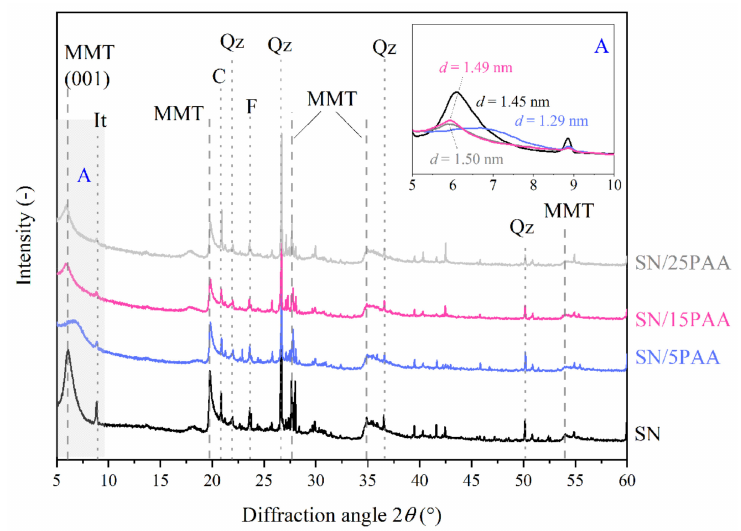
Figure 5. X-ray diffraction patterns of unmodified bentonite SN and modified with poly(acrylic acid) bentonite SN/PAA with distinction into the polymer content (MMT—montmorillonite, It—illite, C—calcite, Qz—quartz, F—feldspar). The A area is a magnification of the XRD pattern in the angle range of 5–10 ◦ .